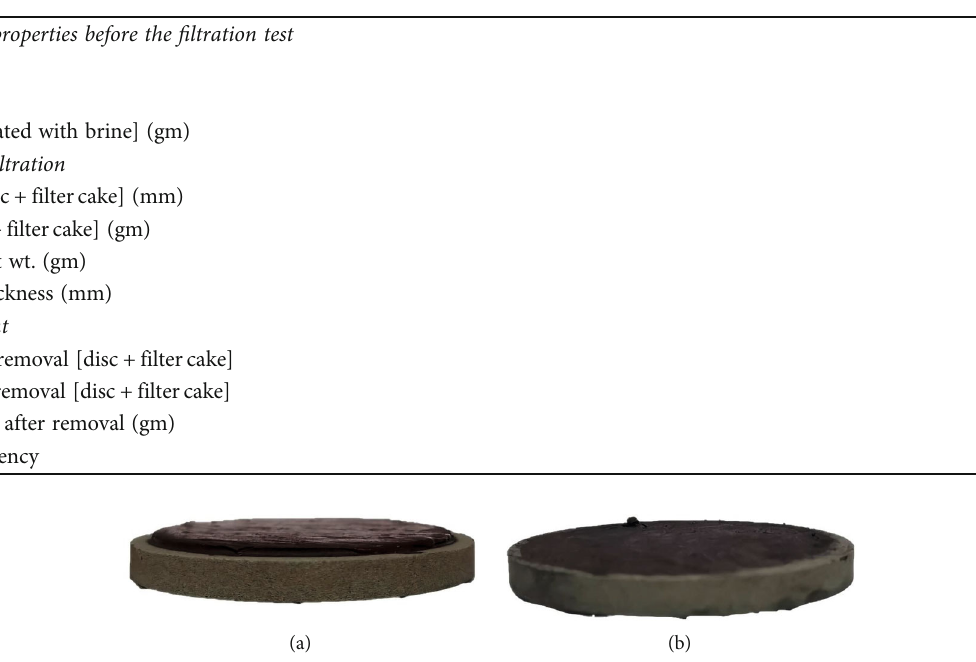
Figure 10: Filtration over 30 minutes. Table 4: Summary of the solubility tests.